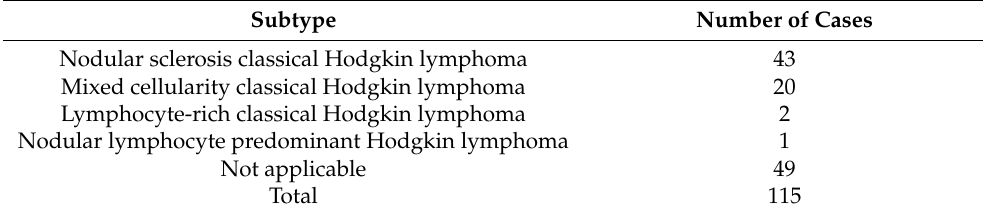
Table 2. Distribution of subtypes.